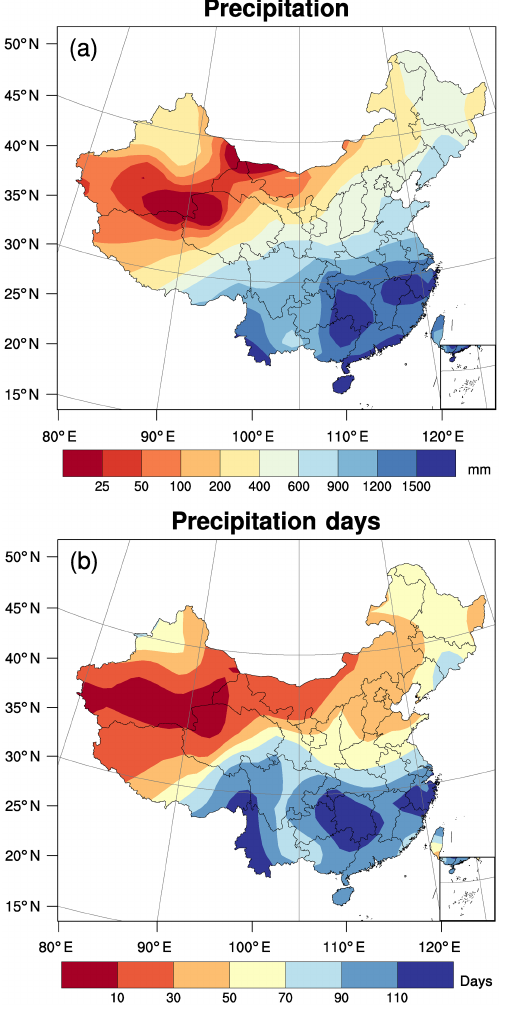
Figure 5. The spatial distribution of annual precipitation (a) and precipitation days (b) during 1985–2014.